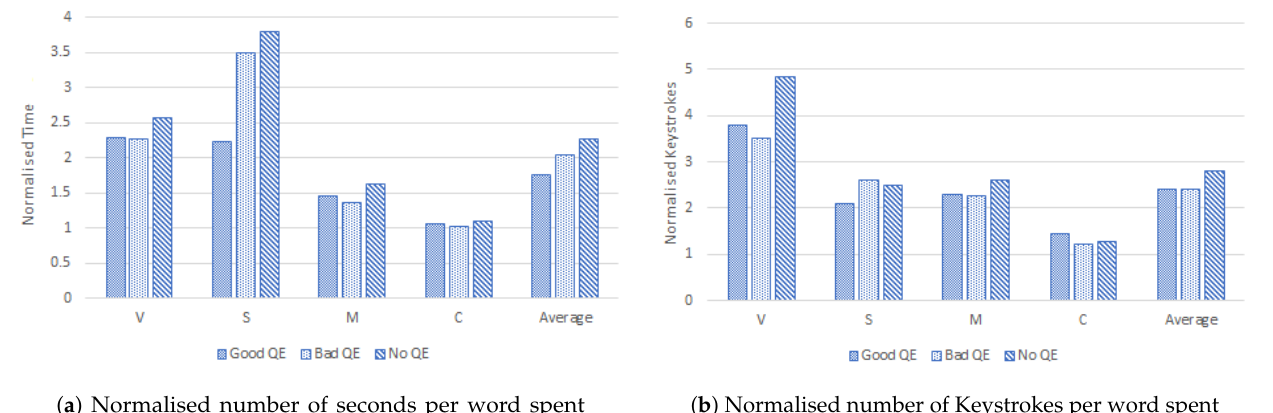
Figure 8. Sentences with FMS > 75.